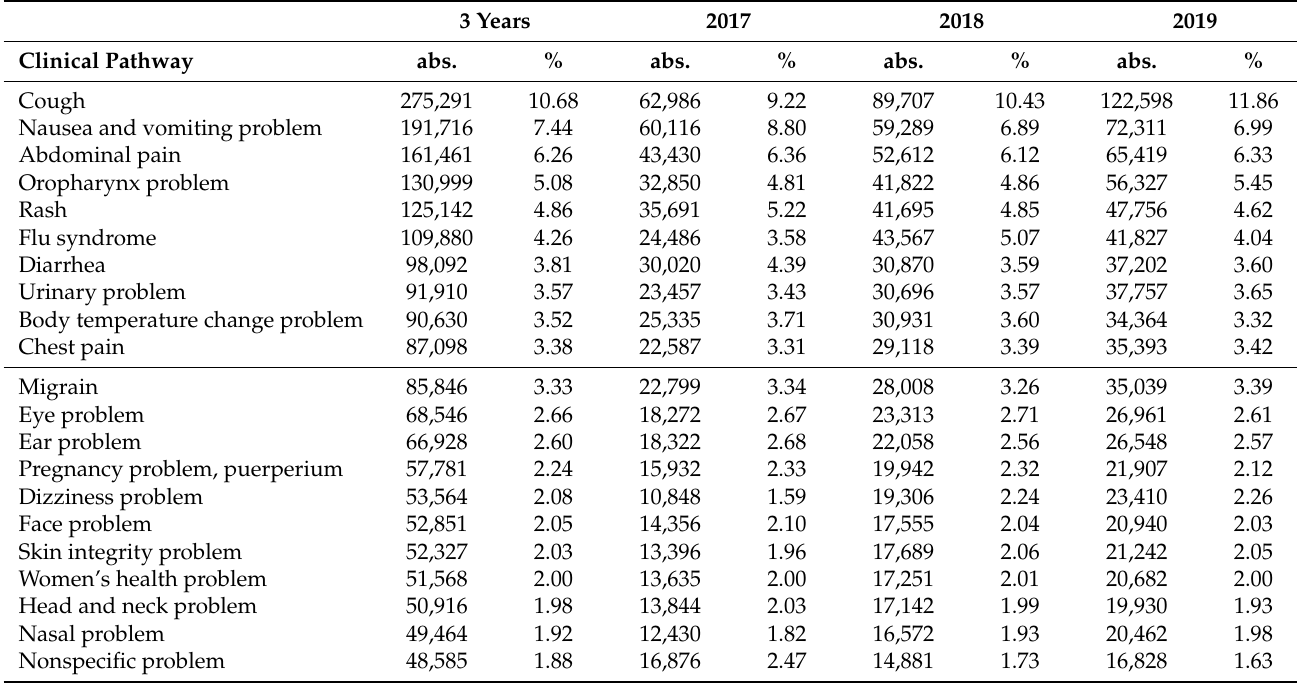
Table A1. Total and per year clinical pathway